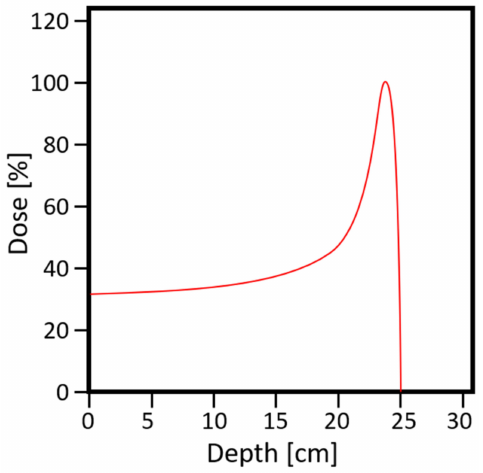
Figure 1. Characteristic dose distribution of the proton